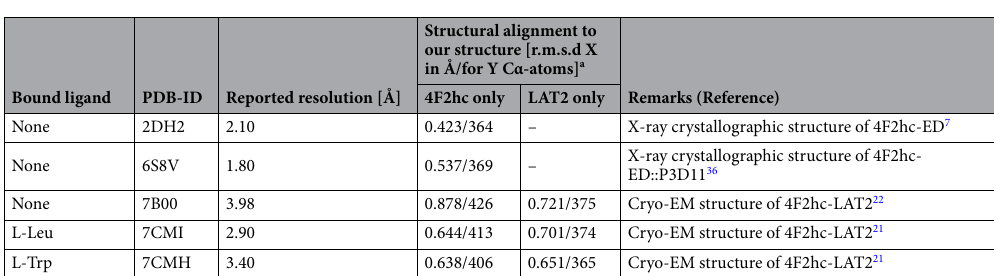
Table 1. Comparison between the structure described here and previously published 4F2hc-ED and 4F2hc- LAT2 structures. a Alignments were calculated using the command "align” in PyMOL version v2.5.2 (The PyMol Molecular Graphics System,